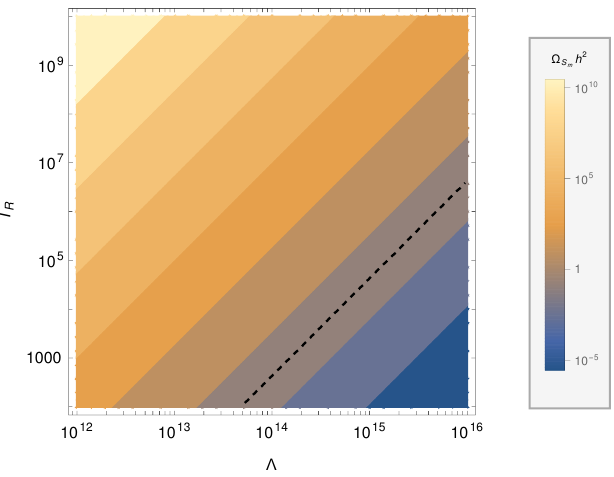
Figure 7 . FIMP DM relic density in terms of Λ and the reheating temperature T R in units of GeV. The black dashed line indicates the correct relic abundance. Here, M = 100 GeV is chosen. One S m may notice that low values of T are preferred to obtain a correct relic R